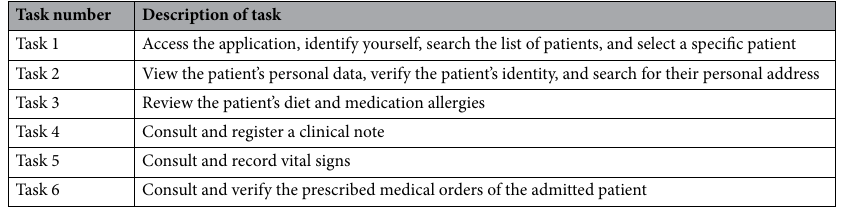
Table 1. Tasks evaluated in the usability